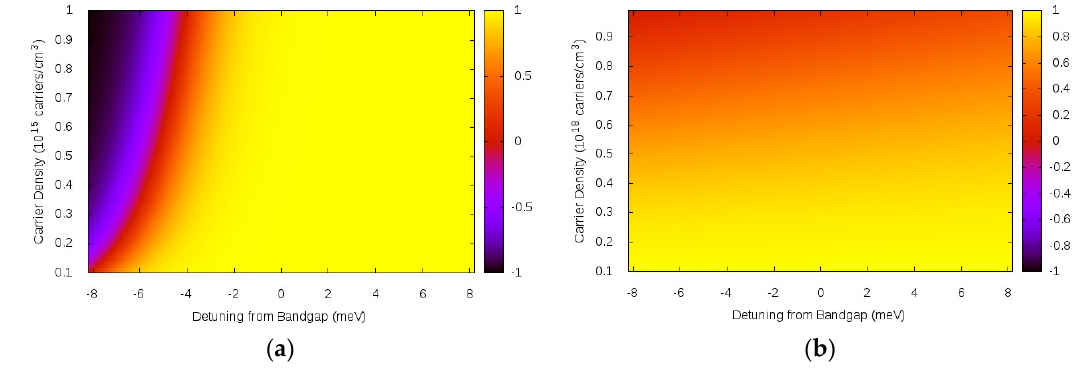
Figure 4. Inversion factor, ϑ ≡ tanh [ β ( (cid:125) ω − µ ) /2 ] for GaAs as function of Detuning from Bangdap = (cid:125) ω − E g and ranges of densities consistent with low temperature luminescence, ( a ) T = 10 K [7–9] and ( b ) high temperature nonlinear absorption T = 300 K